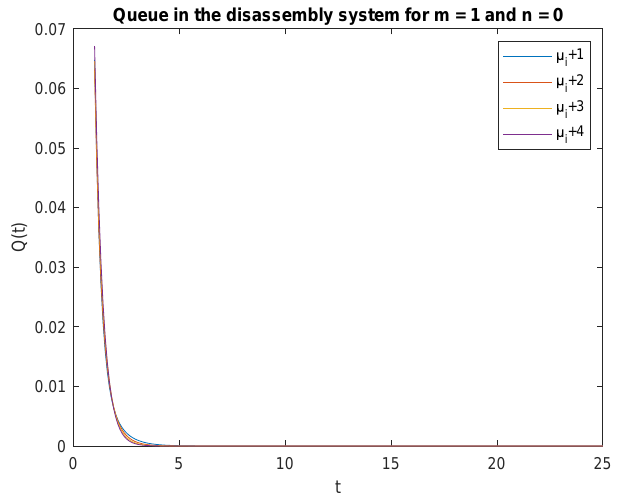
Figure 14. Impact of disassembly rate on probability P { X ( t ) = 1 | X ( 0 ) = 0 } for λ = 4.